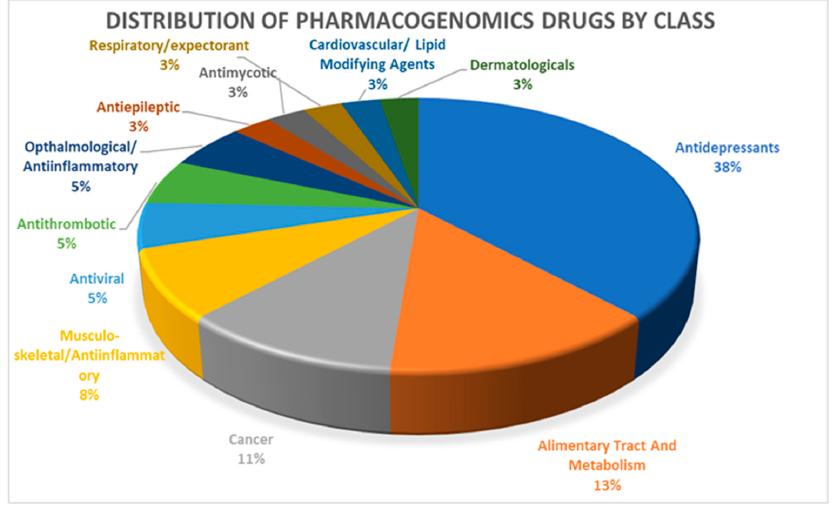
Figure 1. Distribution of 37 pharmacogenomic drugs by class.